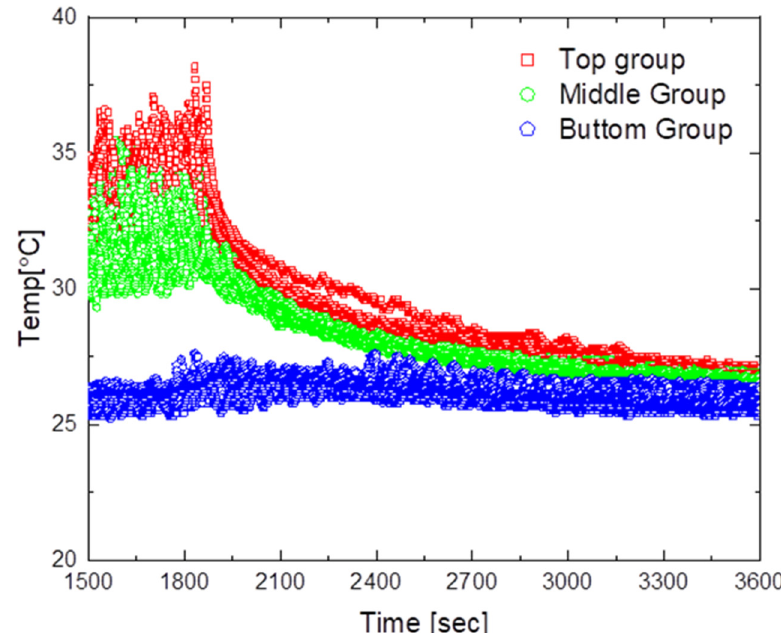
Figure 12. Temperature distribution for the air circulator operating at 2 m/s.